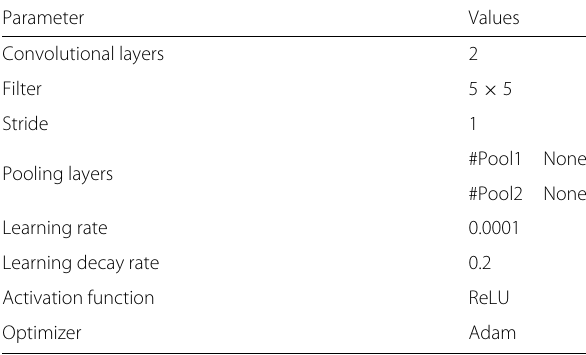
Table 2 Adopted values for each parameters of PERCNN